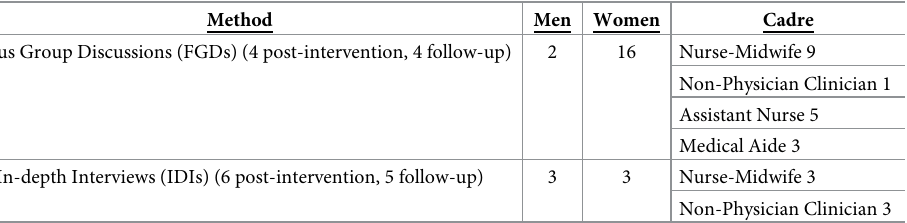
Table 1. Participant